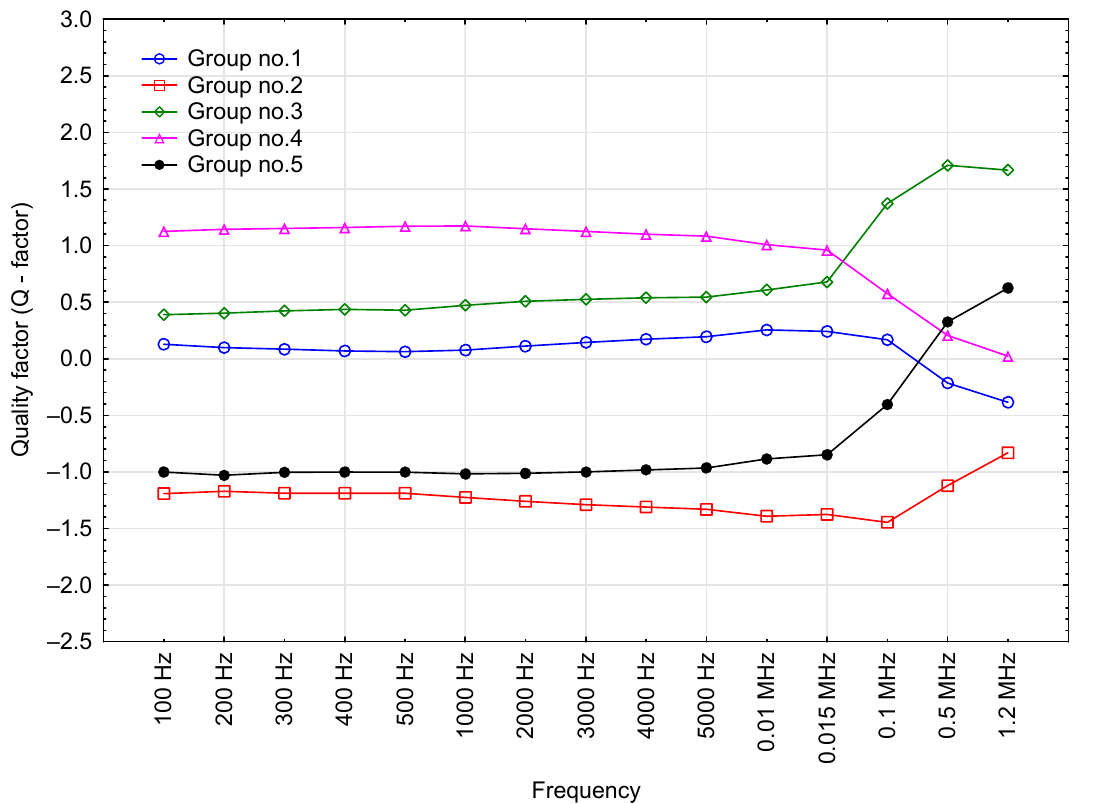
Figure 10. Effect of test voltage frequency on the average Q- factor value of engine oils in each cluster (grouped by k-means). Table 5. Assignment of the oils into the different groupings according to similarity in Q-factor (qual- ity factor) values.